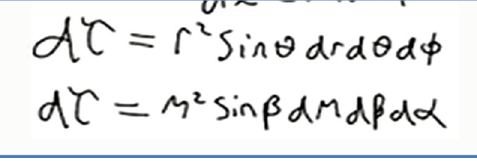
FIG. 6. Tyler ’ s determination of a schmerical differential volume by comparison to spherical. Tyler unknowingly uses mathematics conventions for spherical